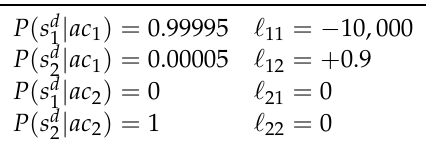
Figure 4. Driving manoeuvres in generated road driving environment in Donkey simulator at a given timeframe [16]. Table 1. The initial values for states and transition